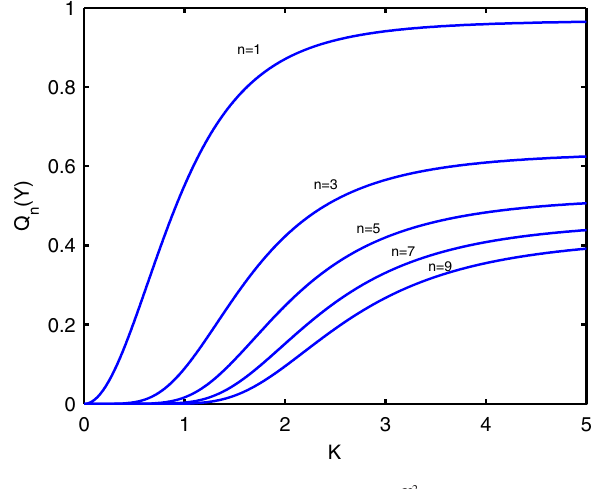
FIG. 2. Function Q